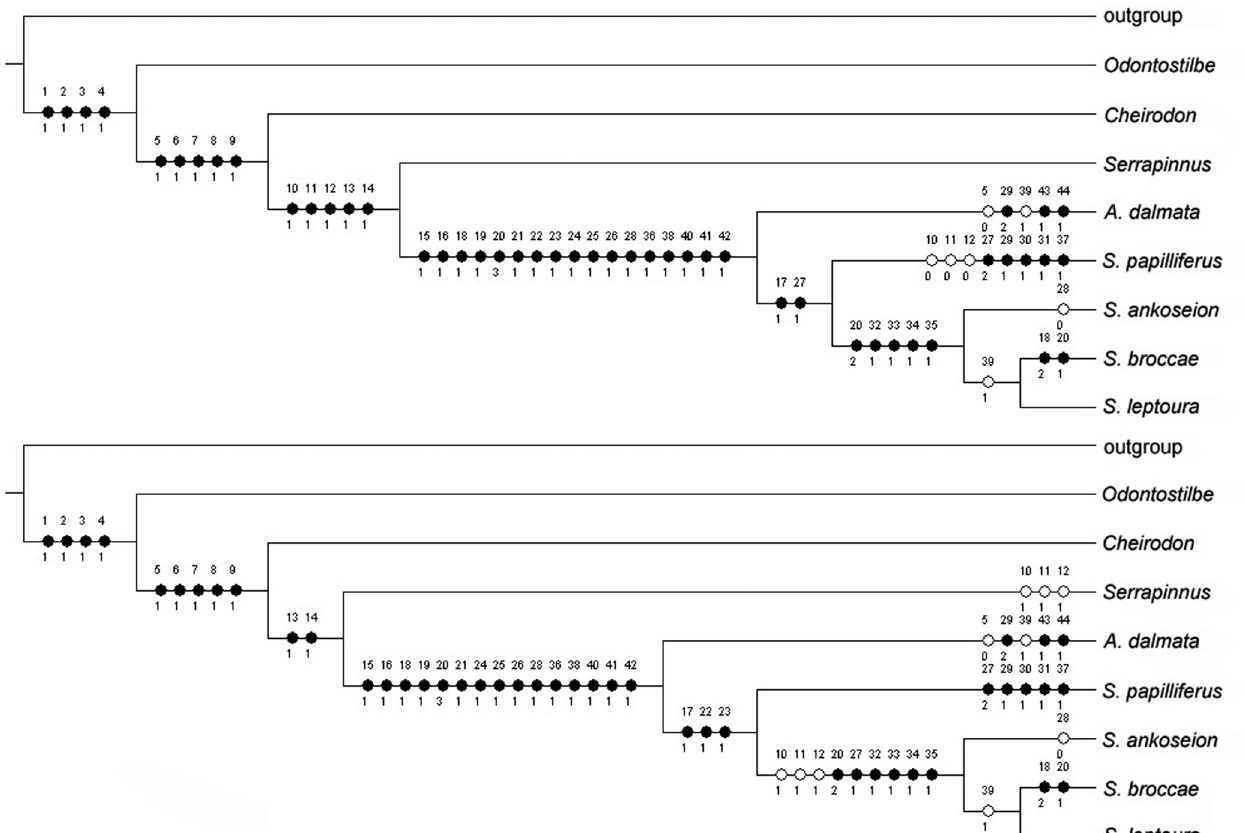
Fig. 10. Phylogeny of Amazonspinther dalmata and related cheirodontine taxa based on the single resulting most parcimoni- ous tree (tree length = 53, Consistency Index = 0.88, Retention Index = 0.92). Characters 6, 7, 8, 9, 10, 11, 12, 13, 14, 22, 23, 28, 32 and 37 were coded as missing in the data matrix for A. dalmata . Characters 10, 11, 12, 22, 23, 27 are ambiguous and were optimized using ACCTRAN (above) or DELTRAN (below)